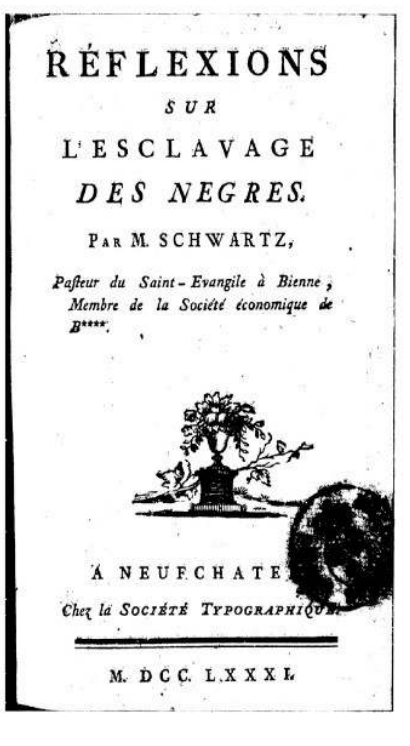
Épître dédicatoire aux nègres esclaves A dedicatory letter to the Negro slaves Mes amis, My